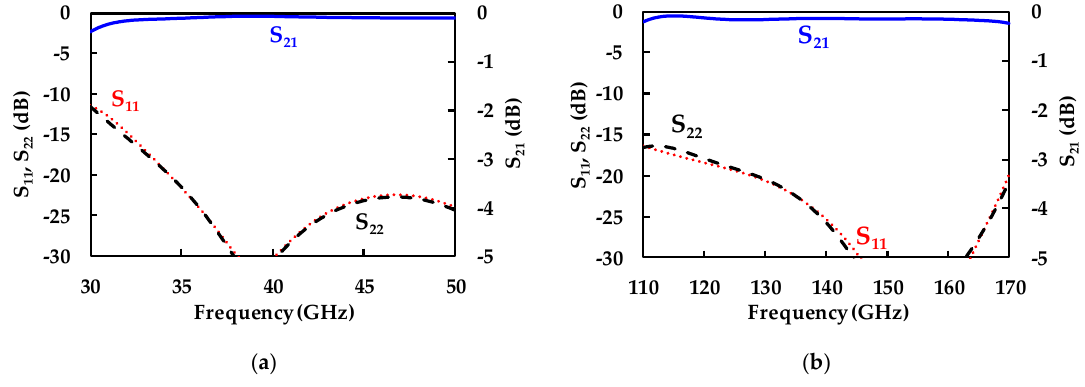
Figure 8. Simulated S ‐ parameters of the designed waveguide transition. ( a ) Q ‐ band transition. ( b ) D ‐ band transition.